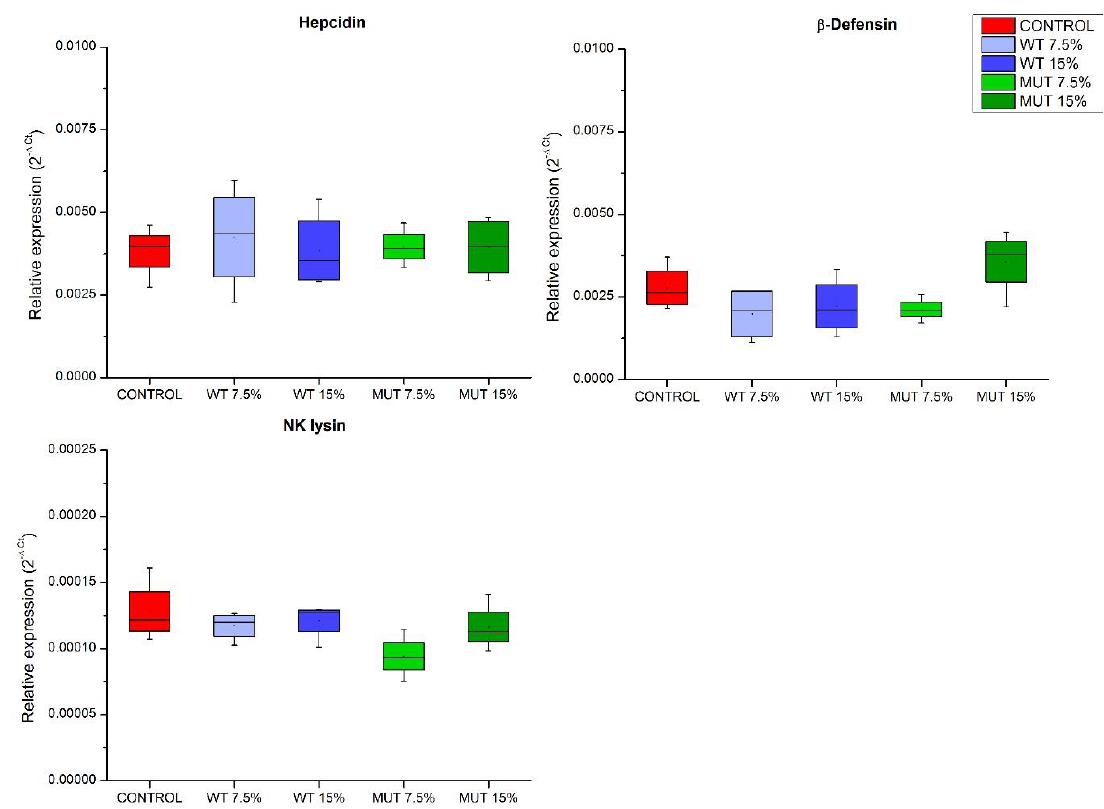
Figure 4. Expression of antimicrobial peptide genes in the gut of zebrafish fed diets supplemented with Lobosphaera incisa wild type (WT) and mutant strain (MUT). Values in box plots show relative gene-expression levels normalized to EF1α and expressed as 2 −Δ C t ( n = 4 biological replicates, each replicate is a pool of five fish). Different lowercase letters denote significant differences ( p < 0.05) between treatments.